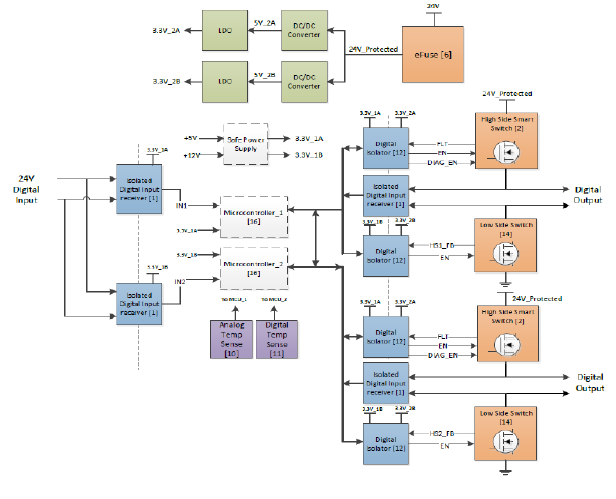
Table 2. Diagnostic coverage of proposed method